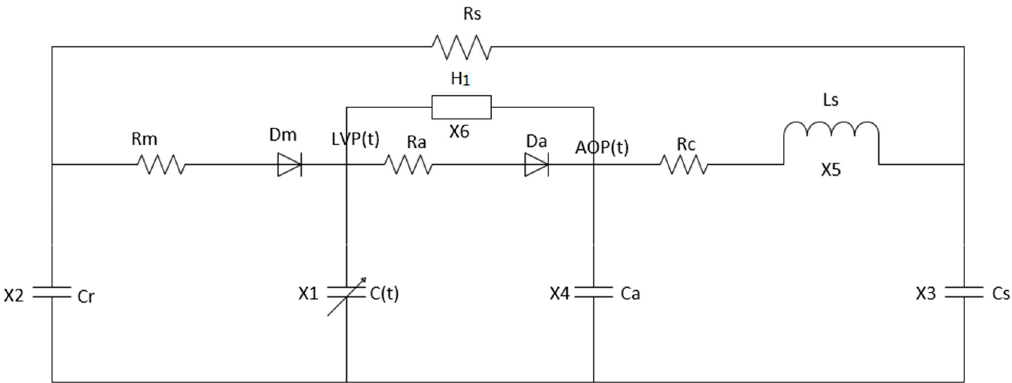
Figure 5. The model of centrifugal blood pump—left heart blood circulation. Table 3. Parameters used in the model.